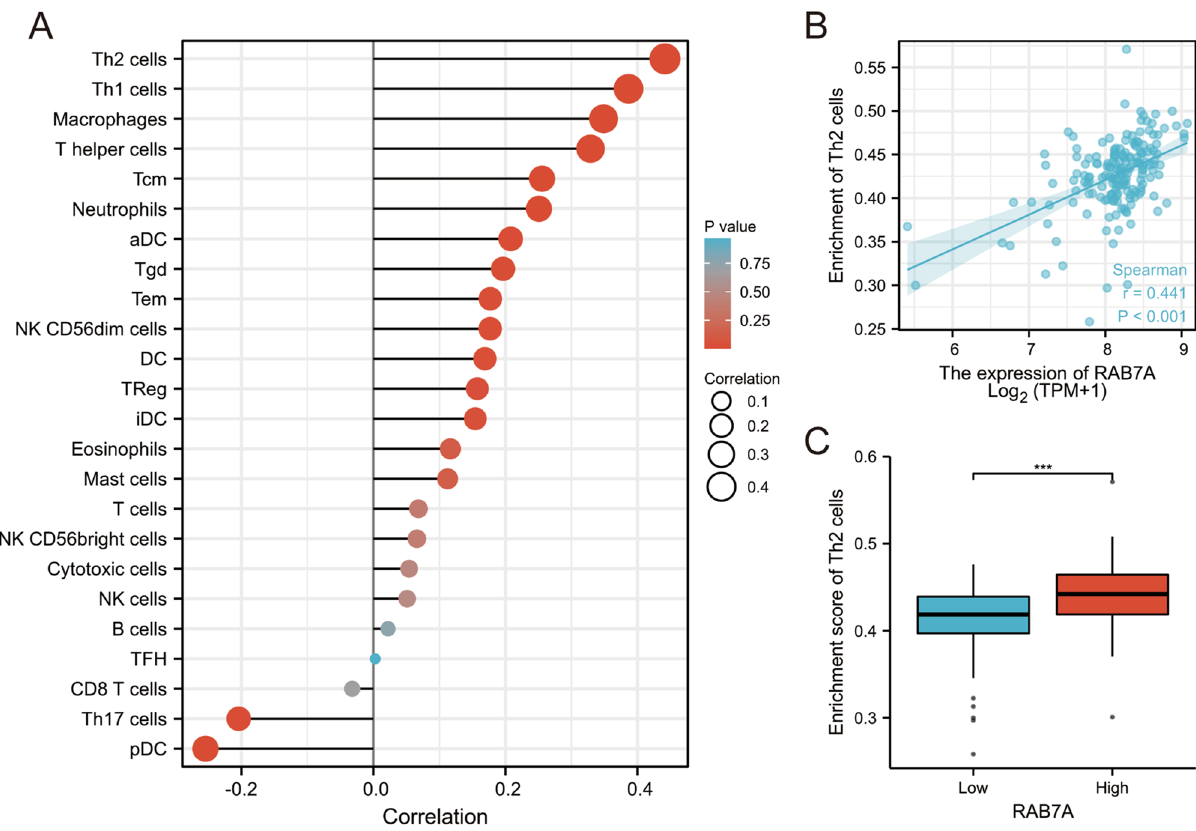
Figure 5. RAB7A expression levels were found to correlate with immune infiltration in the PAAD microenvironment. ( A ) RAB7A had a negative correlation with 3 immune cell subsets and a positive correlation with 21 immune cell subsets. ( B ) The relative enrichment of Th2 cells was positively correlated with the level of RAB7A expression (TPM). ( C ) Infiltration of Th2 cells between low and high RAB7A expression.